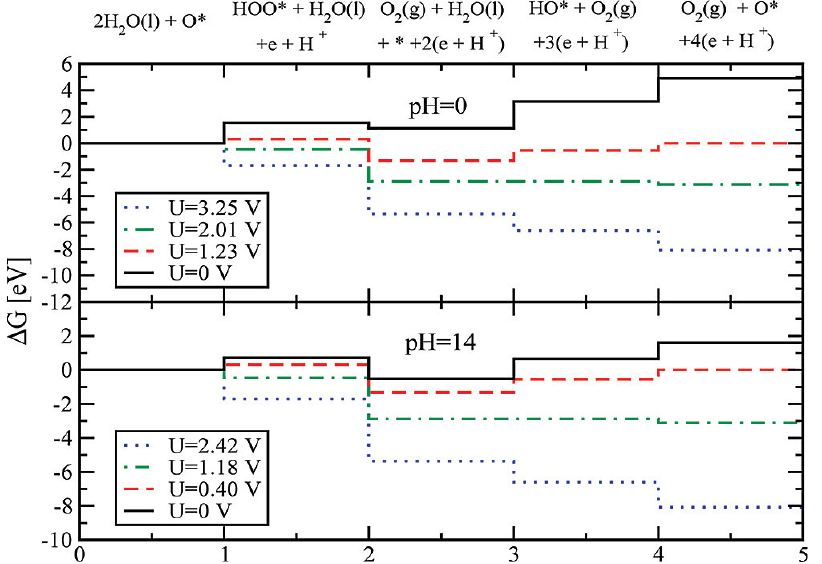
Figure 5. For the S 2 surface termination of TiO 2 the free energies of the intermediates at pH = 0(14) ( U = 0, 1.23(0.40), and 2.01(1.18) V) are presented. Some reaction steps are uphill in free energy at the equilibrium potential ( U = 1.23(0.40) V). All reaction steps are downhill in free energy at U = 2.01(1.18) V and pH = 0/14. For the photogenerated holes, the corresponding values of redox poten- tial vs. NHE in the valence band TiO 2 (rutile) in contact with H 2 O under irradiation at pH = 0(14) are also compared. (Reprinted from ref. [49] with permission from the American Chemical Society.